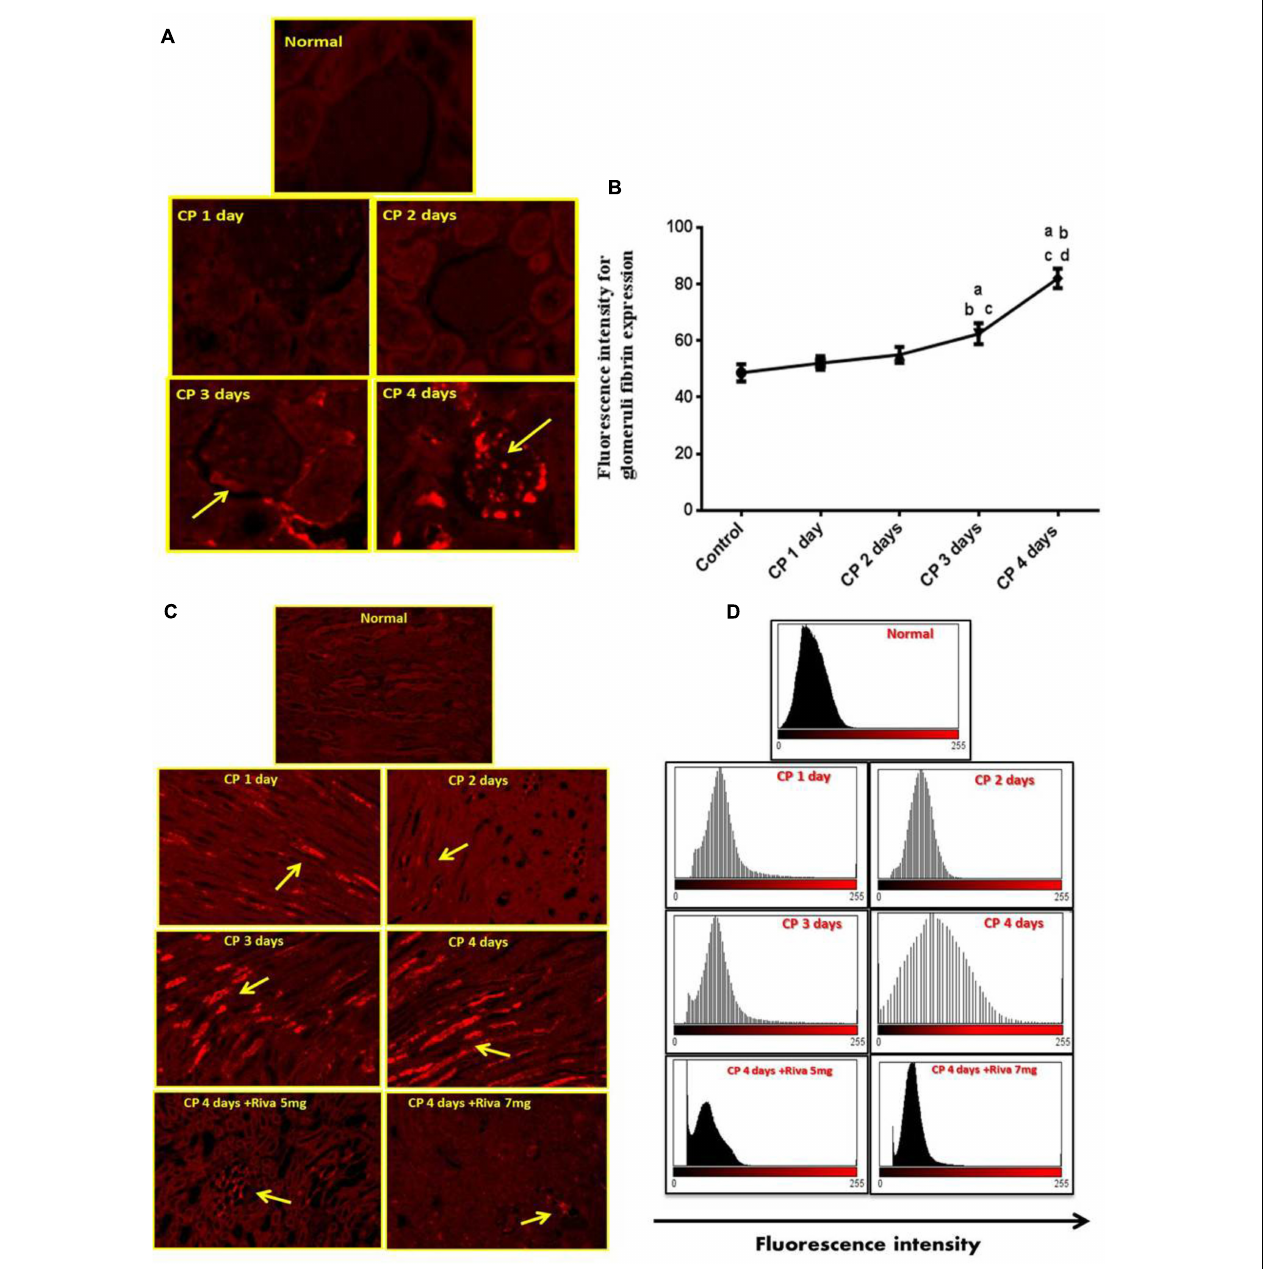
FIGURE 2 | Effect of cisplatin (CP) with or without rivaroxaban (Riva) on fibrin expression: (A) Immunofluorescence staining of renal glomeruli of fibrin in normal and CP (6 mg/kg b.w) treated rats after 1, 2, 3 and 4 days, showing moderate to highly expression of fibrin in the glomerular cells after 3 and 4 days, respectively (yellow arrow) as compared to normal control. (B) Graphical presentation of fibrin fluorescence intensity in normal and cisplatin treated animals from day 1 to day 4 where (a) Significantly different from control group at p ≤ 0.01 (b) Significantly different from CP 1 day at p ≤ 0.01. (c) Significantly different from CP 2 day at p ≤ 0.01. (d) Significantly different from CP 3 day at p ≤ 0.01. (C) Immunofluorescence staining of renal tubular cells in normal and cisplatin (6 mg/kg) treated rats after 1, 2, 3, and 4 days in absence or presence of rivaroxaban, showing gradual increase in fibrin expression in renal tubular cells after 1 day till 4 days (yellow arrow). Basal expression of fibrin in the renal tubular cells of cisplatin pretreated with rivaroxaban. (D) Graphical histogram showing fluorescence intensity of fibrin in renal tubular cells of normal group and rats treated with cisplatin in absence or presence of rivaroxaban.